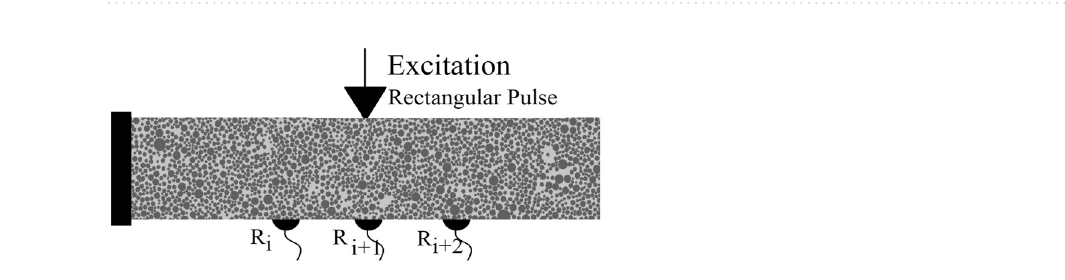
Figure 13. The generated concrete beam structure composed of aggregates and